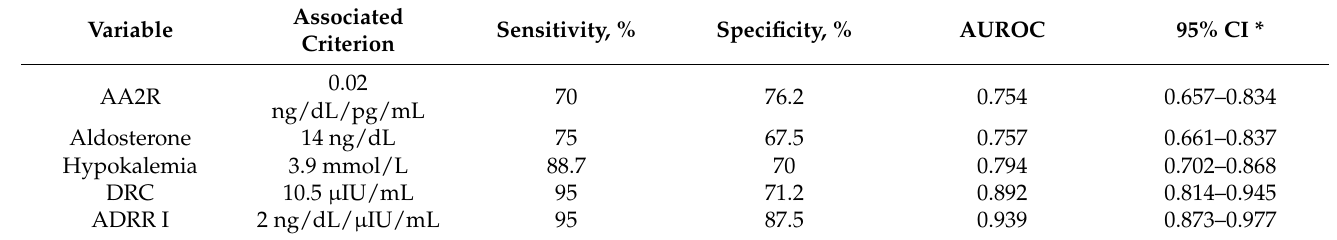
Table 5. Comparison of the chosen parameters of ADRR I, AA2R, aldosterone, DRC, and hypokalemia (all p <